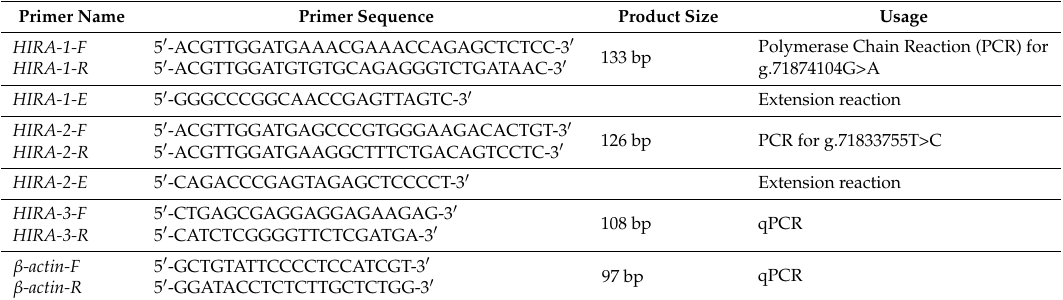
Table 2. HIRA primer